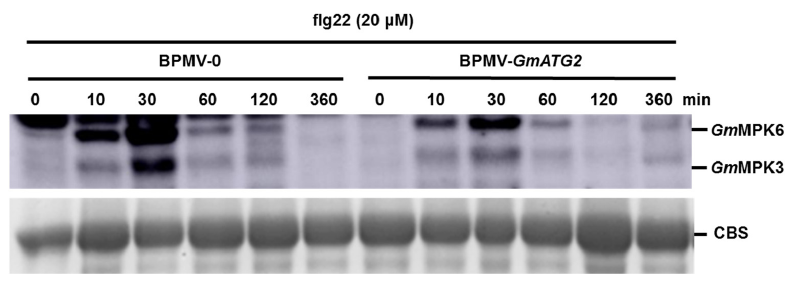
Figure 6. The activation of Gm MPK3/6 in response to flg22 is reduced in GmATG2 -silenced plants relative to BPMV-0 plants. Leaf discs collected from BPMV-0 and BPMV- GmATG2 plants were incubated on moist filter paper for 24 h to allow recovery from wounding before treatment with 10 µM flg22 for the indicated time. The kinase activities were detected by immunoblotting, using phospho-p44/42 MAP Erk1/2 antibody. Coomassie Blue staining (CBS) was performed for loading control. The experiment was repeated twice with a similar result.